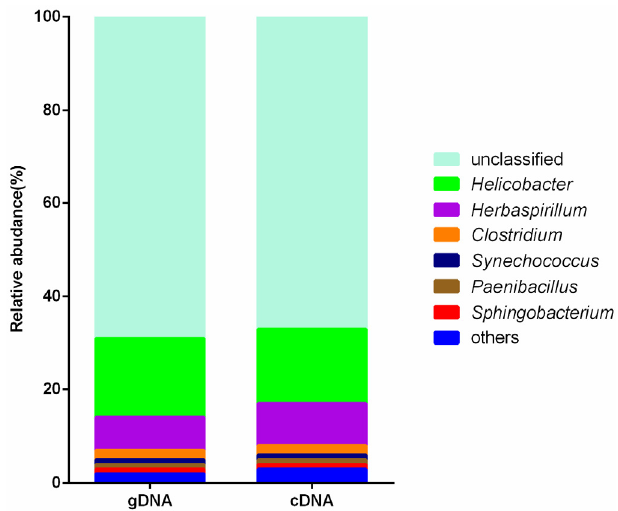
Figure 4. Taxonomy of the ureolytic bacteria components of gDNA and cDNA. The top 7 genera based on relative abundance are presented, the remaining genera grouped as “others”.